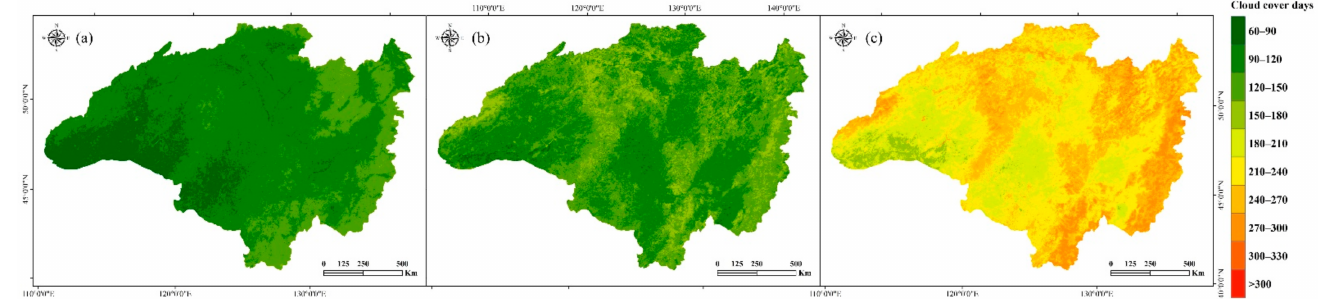
Figure 4. Spatial distribution of cloud cover days in the growing season ( a ), snowing season ( b ), and the whole year ( c ) in the basin.